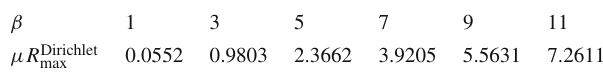
Table 2 Composed charged-reflecting-star-charged-massive-scalar- fieldconfigurations. Wepresent,forvarious valuesofthedimensionless physical parameter β [see Eq. (15)], the largest possible dimension- less radii μ R Dirichlet max (β) of the spherically symmetric charged reflecting stars that can support the spatially regular configurations of the static charged massive scalar fields. One finds that the maximally allowed radii μ R Dirichlet max (β) of the central supporting stars are a monotonically increasing function of the dimensionless star-field physical parameter β . The data presented is for the case α = 0 . 1 [ M μ = 0 . 1, see Eq. (15)], which implies that the assumption R s (cid:2) M is valid for β (cid:3) 3